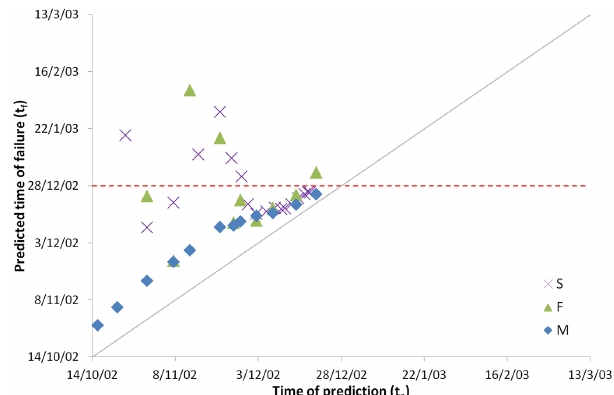
Figure 1. This graph represents probabilistic predictions performed with three different forecasting methods (Fukuzono, 1985a; Mu- fundirwa et al., 2010; Saito, 1969) applied to the MB34–35 (cid:48) dis- placement time series of the Mount Beni landslide (Gigli et al., 2011). The horizontal dashed line indicates the observed time of failure ( T f ) and the grey diagonal line indicates the equality be- tween t f and t p . Therefore, the vertical distance between a point and the dashed line indicates the prediction error. The vertical dis- tance between the diagonal line and a prediction above it is the life expectancy of the landslide at the time of prediction. In this case the predictions obtained through the S and F methods give a good estimation of T f , while the one from Mufundirwa et al. (2010) con- sistently forecasts the collapse a few days